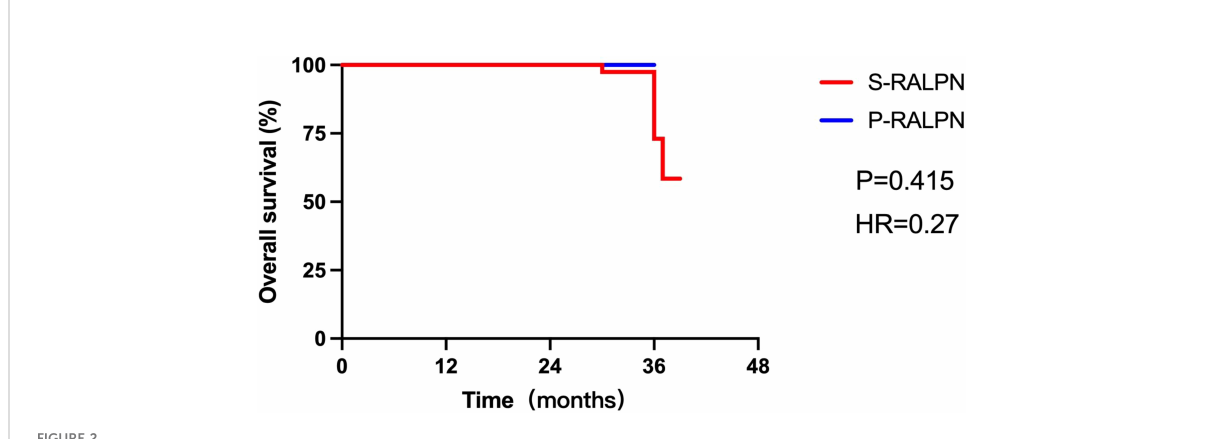
FIGURE 2 The schematic diagram of the